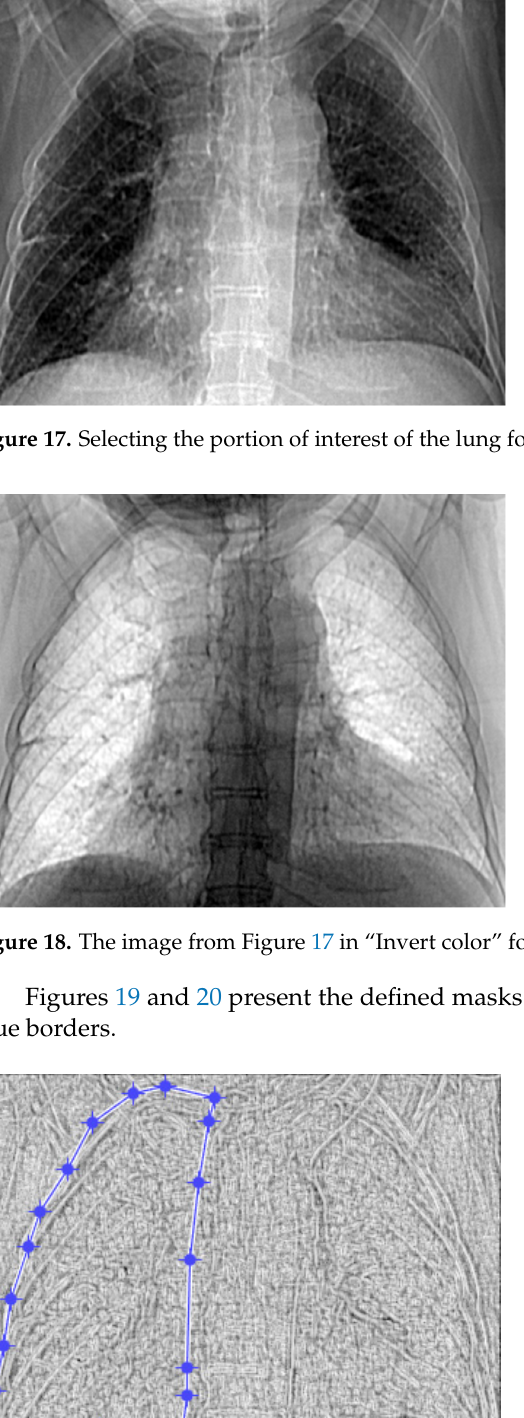
Figure 16. Three-dimensional graphical representation of voxels in the third patient(cid:31)s CT lung image.